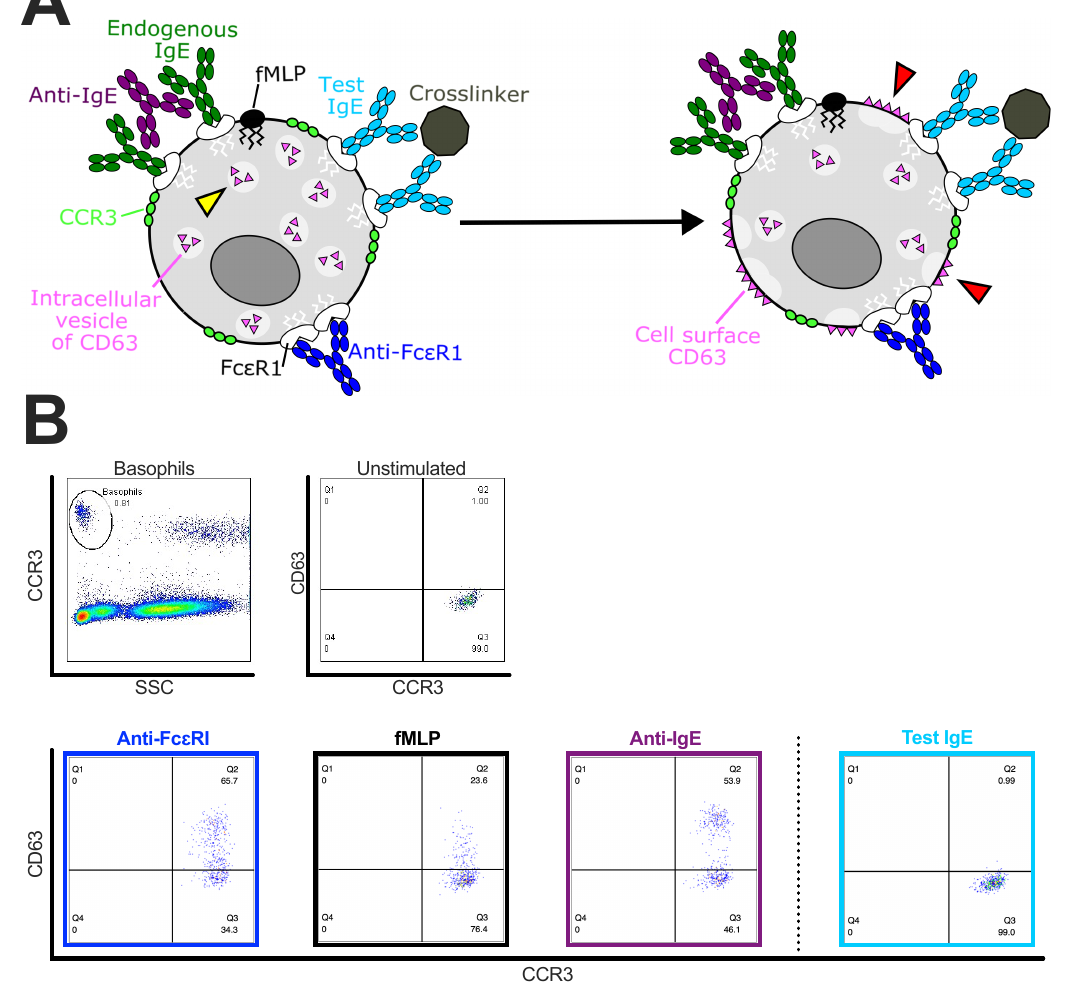
Figure 4. Example of the basophil activation test (BAT) to evaluate the propensity of an anti-FR α IgE antibody (MOv18 IgE) to trigger human basophil activation. ( A ) Schematic of basophil containing intracellular vesicles of CD63 (yellow arrow) and the mechanism of action of stimuli (left). Stimuli include either IgE-mediated (anti-Fc ε RI or anti-IgE and potential crosslinker of test IgE) or non-IgE- mediated (fMLP). Stimulation of basophils subsequently causes intracellular vesicles of CD63 to fuse with cell surface membrane on the basophil cell surface (red arrows) (right). Basophils can be identified from unfractionated whole blood samples by expression of the CCR3 cell surface marker (left). The change in CD63 surface expression is measured following incubation of basophils with stimuli (right). ( B ) Top: Representative flow cytometric dot plots of human blood cells gated for CCR3 high SSC low basophil populations (left). Dot plots of unstimulated CCR3 + basophils that express low levels of the activation marker CD63 on the cell surface (right). Bottom: When stimulated by one of the three positive control stimuli (anti-Fc ε RI, navy blue box; fMLP, black box; anti-IgE, purple box) a marked upregulation of CD63-expressing CCR3 + basophils is observed. No CD63 expression is observed when the same patient’s blood is incubated with a test IgE (right, light blue box). This indicates that this representative patient would likely not develop hypersensitivity to this test IgE upon intravenous administration of this